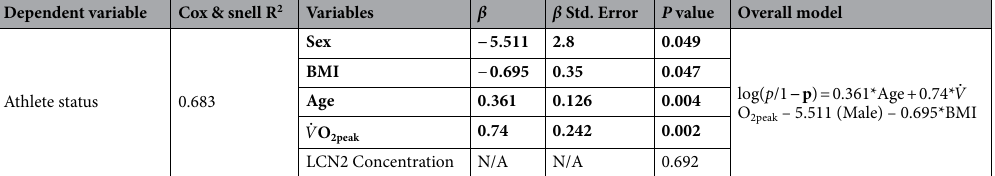
Table 2. Results of sensitivity analysis performed on athlete status of an individual testing cohort demographic and cardiovascular health characteristics as well as LCN2 concentration. Athletes were assigned as 1 in the dataset, while controls were assigned as 0. The overall model describes the relationship between significant predictors of athlete status and the predicted log odds of the individual tested being an athlete. The model correctly predicted athlete status in 94.8% of individuals in our dataset. BMI, body mass index; SBP, systolic blood pressure; DBP, diastolic blood pressure; LCN2, lipocalin-2; (cardiorespiratory)